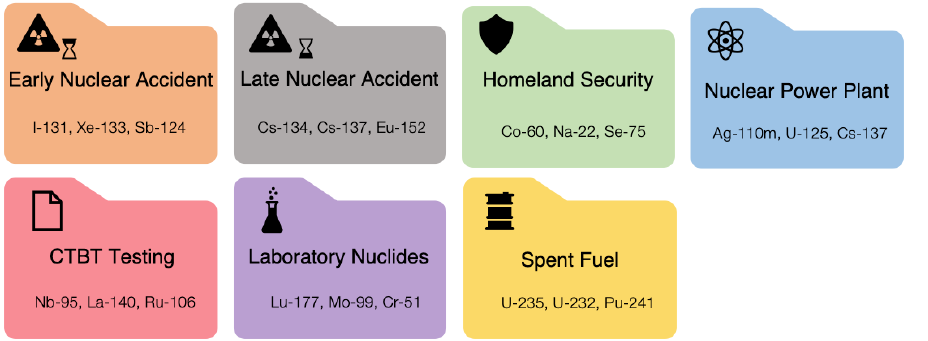
Figure 3. Schematic of the seven predefined isotope ’libraries’ and subset of radioisotopes within, of which the most applicable suite is selected by the user based upon the specific